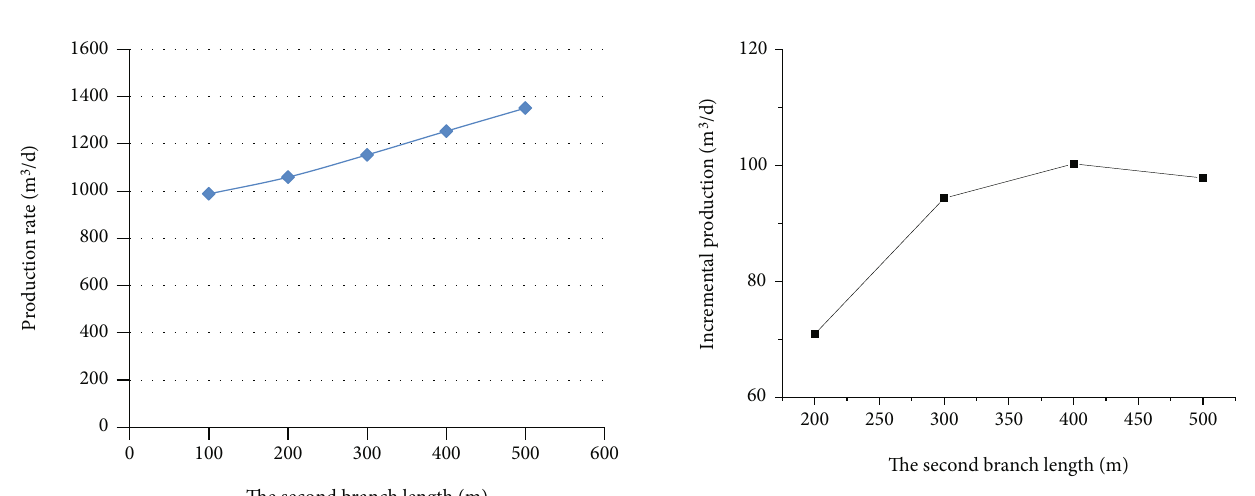
Figure 14: Incremental production with di ff erent length conditions of the second